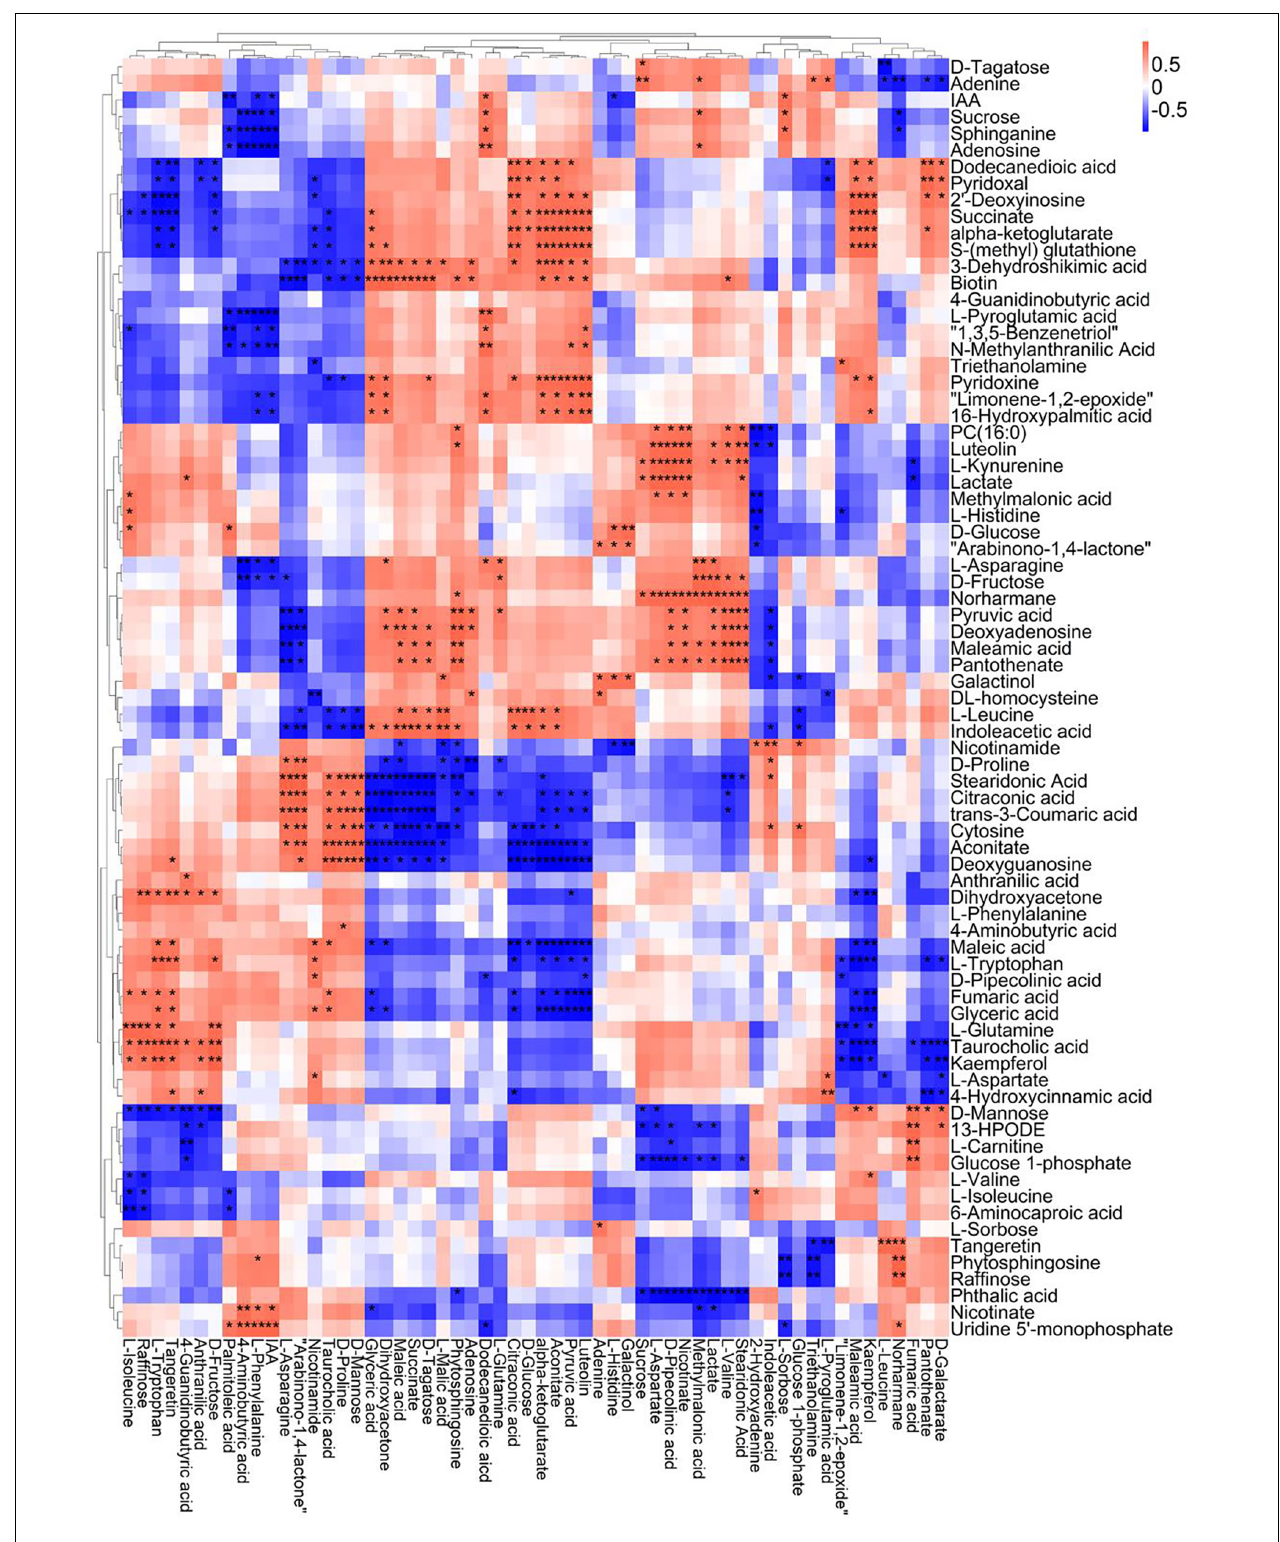
FIGURE 8 | Correlation analysis of TLP-DN6 leaf metabolites subjected to spaceflight treatment. A correlation matrix was generated using Pearson’s correlation on six biological replicates of CK and SP-treated plants. Red color shows positive correlation whereas blue color represents negative correlation among the metabolites under spaceflight treatment. ** and * indicate significant difference at p < 0.01 and p < 0.05 by Pearson’s correlation test, respectively.